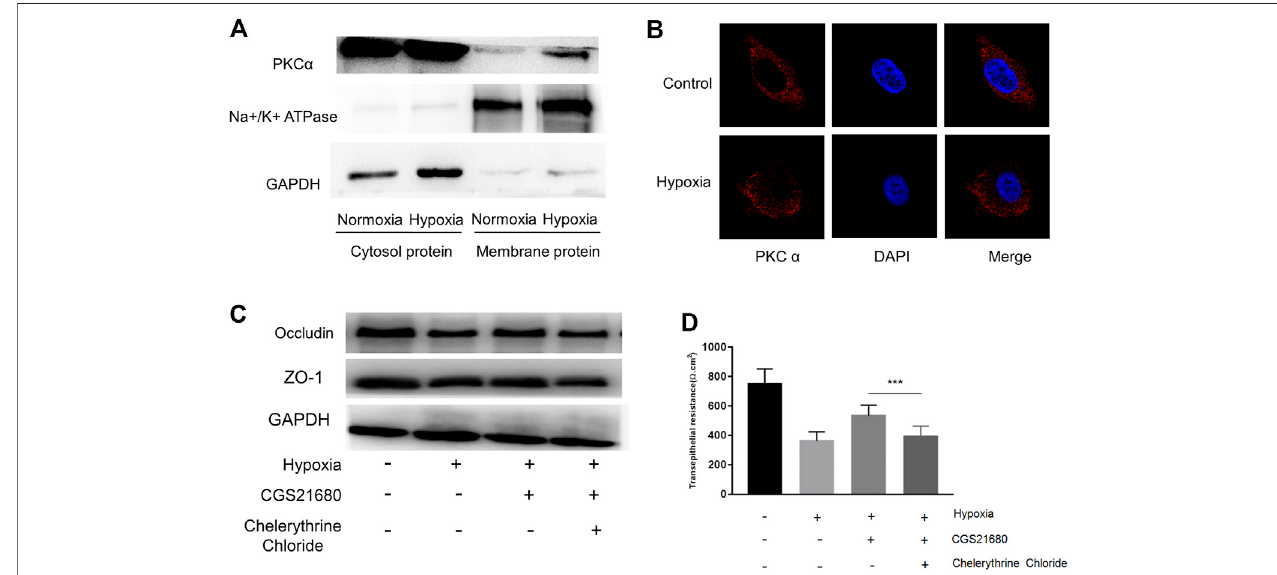
FIGURE5| Theprotectiveeffect ofA 2A R onIEB isPKC α dependent. PKC α expression wasassessed indifferententeric glial cells(EGCs)fractions. (A) Membrane andcytosolproteinswererespectivelyextractedtodetectPKC α changeunderhypoxia. (B) Immuno fl uorescencewasusedtovisualizePKC α distributionunderhypoxia. (C , D) EGCs were co-cultured with Caco-2 monolayers for 24 h, then treated with chelerythrine chloride (10 μ M) and CGS21680 (100 nM) for 6 h under hypoxic conditions. (C) Western blot and (D) TER analysis were used to detect the function of IEB. Results are expressed as mean ± SD. (*** p <